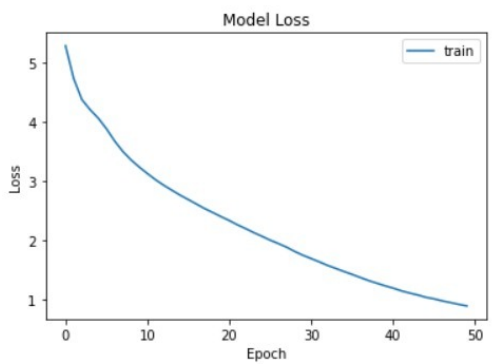
Fig. 8. Epoch vs Loss Graph